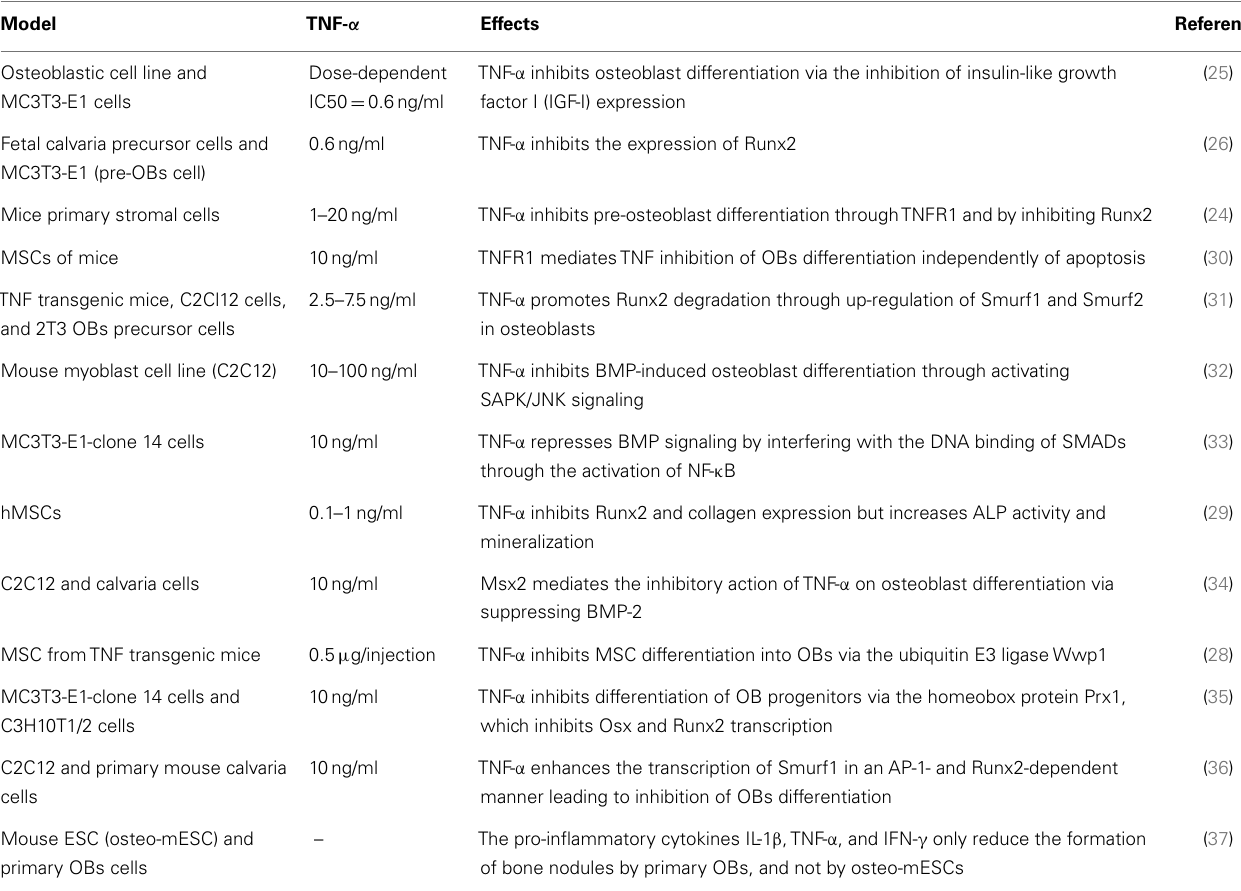
Table 1 | Overview of studies indicating aTNF-mediated inhibition of osteogenic differentiation